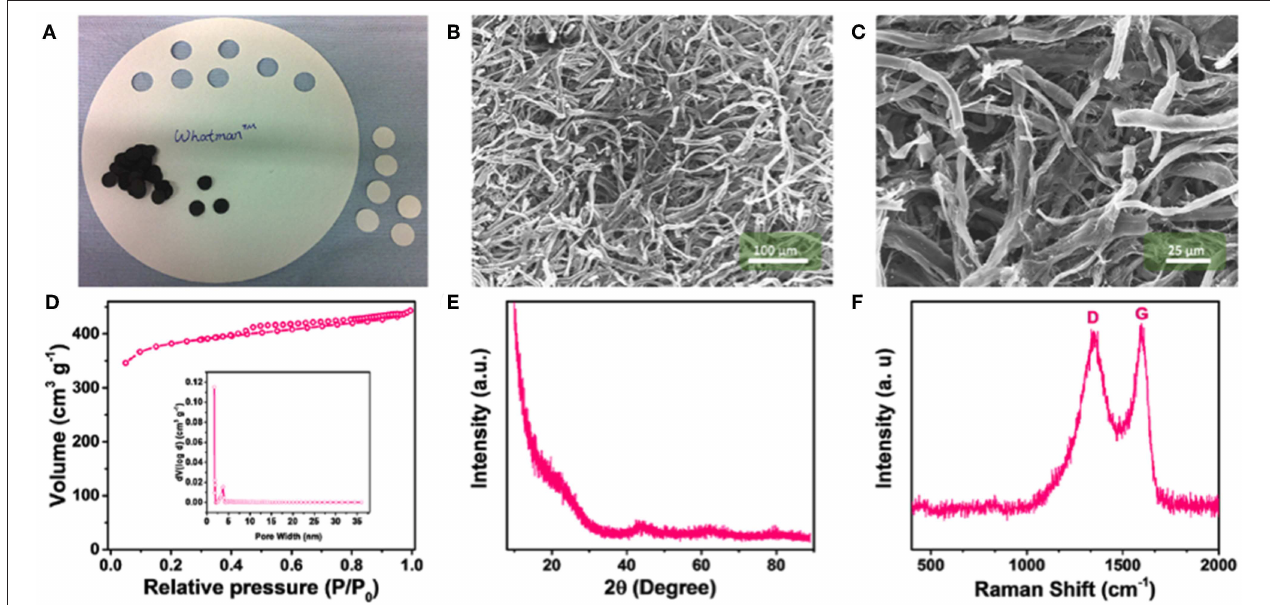
FIGURE 1 | Characterization of the paper-derived carbon network (CNW) material: (A) Photograph of the filter paper and as-prepared, free-standing CNWs; SEM images of the CNW with different magnifications, i.e., (B) 500x and (C) 1,500x; (D) nitrogen adsorption-desorption isotherm and pore size distribution of the CNW (inset); (E) XRD pattern; and (F) Raman spectrum of the